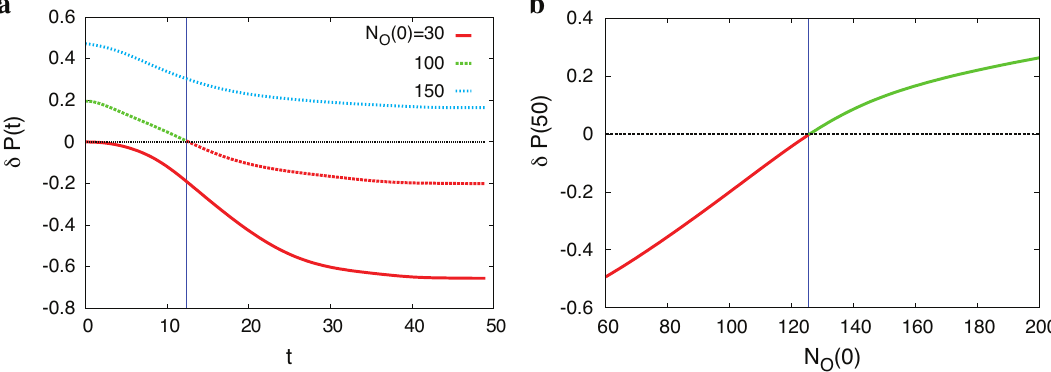
Figure 4. How the initial number of observed signs determines the range of useful predictions with a probabilistic model. ( a ) The difference δ P ( t ) = P ( T R probabilities of the first correct and incorrect diagnosis times ( T R and T W , respectively) is plotted against the number of observations t for different numbers of initial observations, N O ( 0 ) . ( b ) δ P ( 50 ) is plotted against N O ( 0 ) for a sufficiently large value of t . The numbers of signs and diseases in this example are N S = 500 and N D = 50. (Adapted from reference